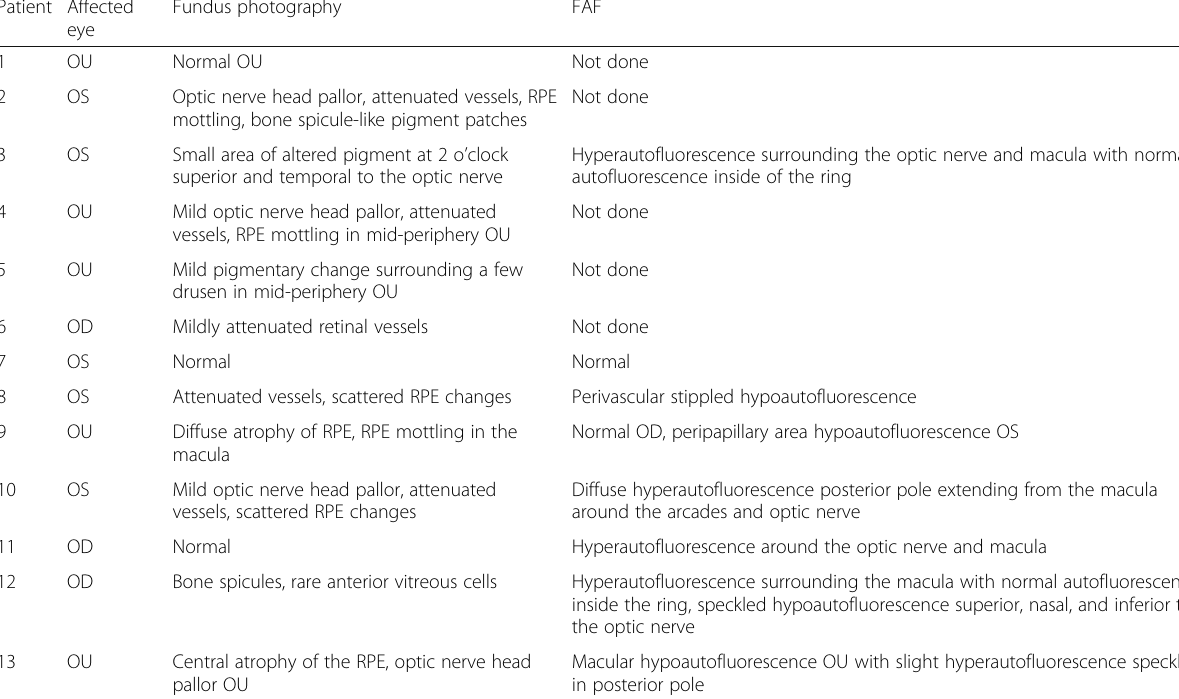
Table 3 Characteristics of fundus photography and fundus autofluorescence for all 13 patients with npAIR Patient Affected Fundus eye